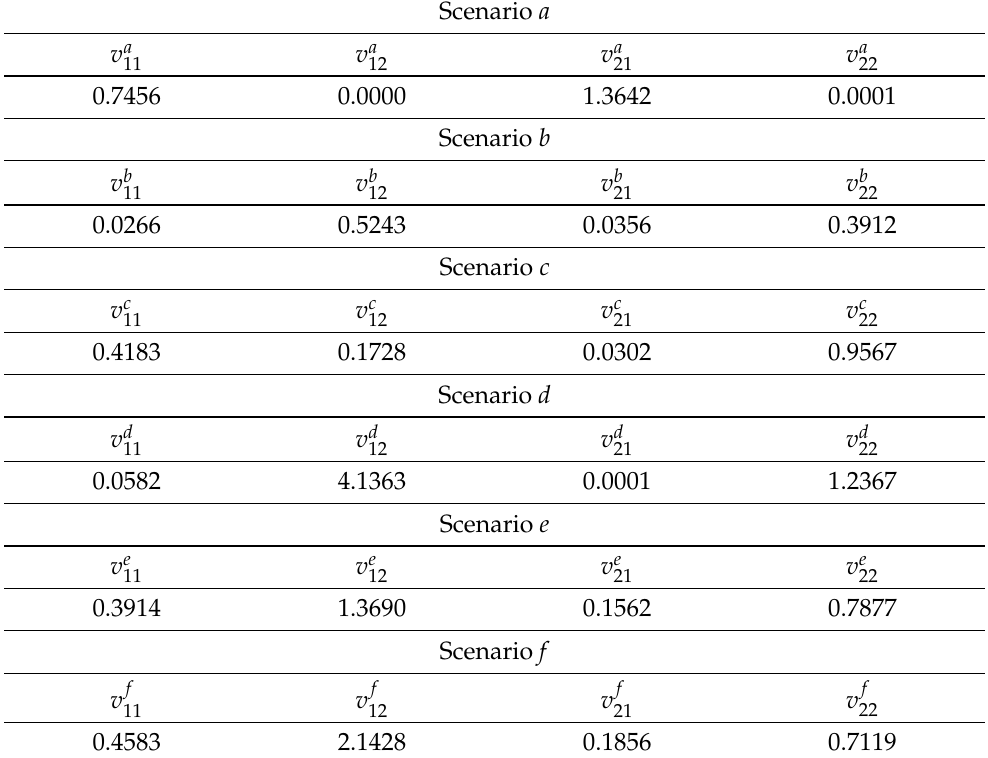
Table 1. Estimated parameters v i intra-juvenile virulence; v i intra-elder virulence].